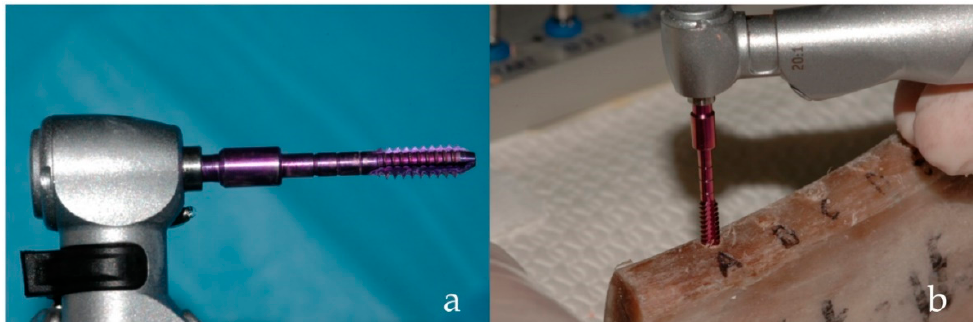
Figure 2. The probe used to measure the density of the bone specimen. The probe has an inverse cone shape ( a ), enabling measurement the friction encountered by the first thread only during its descent ( b ). The average of all instantaneous torque values measured throughout the probe’s descent, Cm, has been shown to be a reliable measurement of bone density [46].